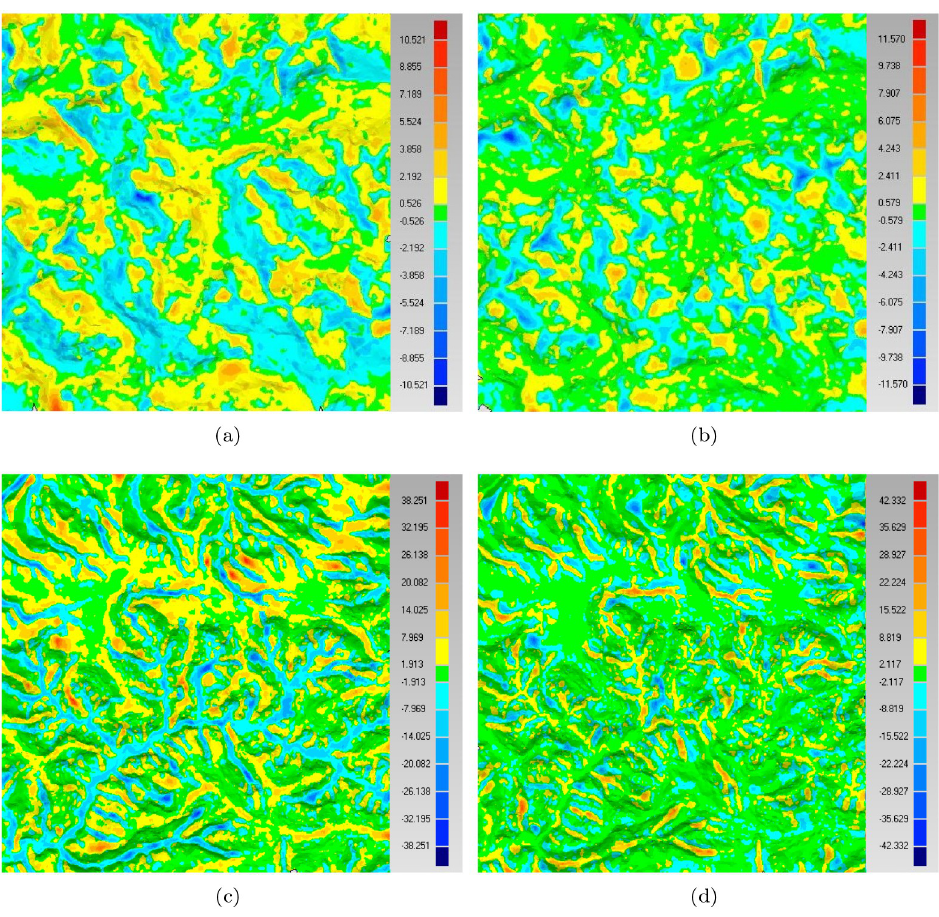
Fig 9. The reconstruction error distribution. (a) is the reconstruction error of geodesic distance based maximal Poisson-disk sampling, (b) is our result. Correspondingly, (c) and (d) are the reconstruction errors of data 1.